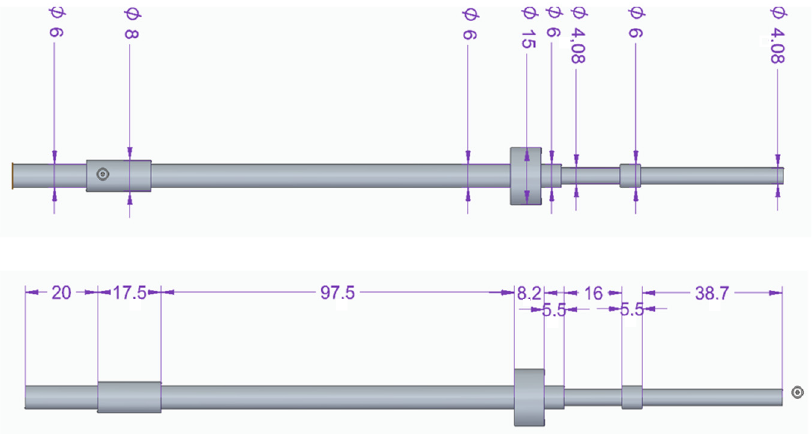
Figure 5. Shaft Figure 5. Shaft layout.